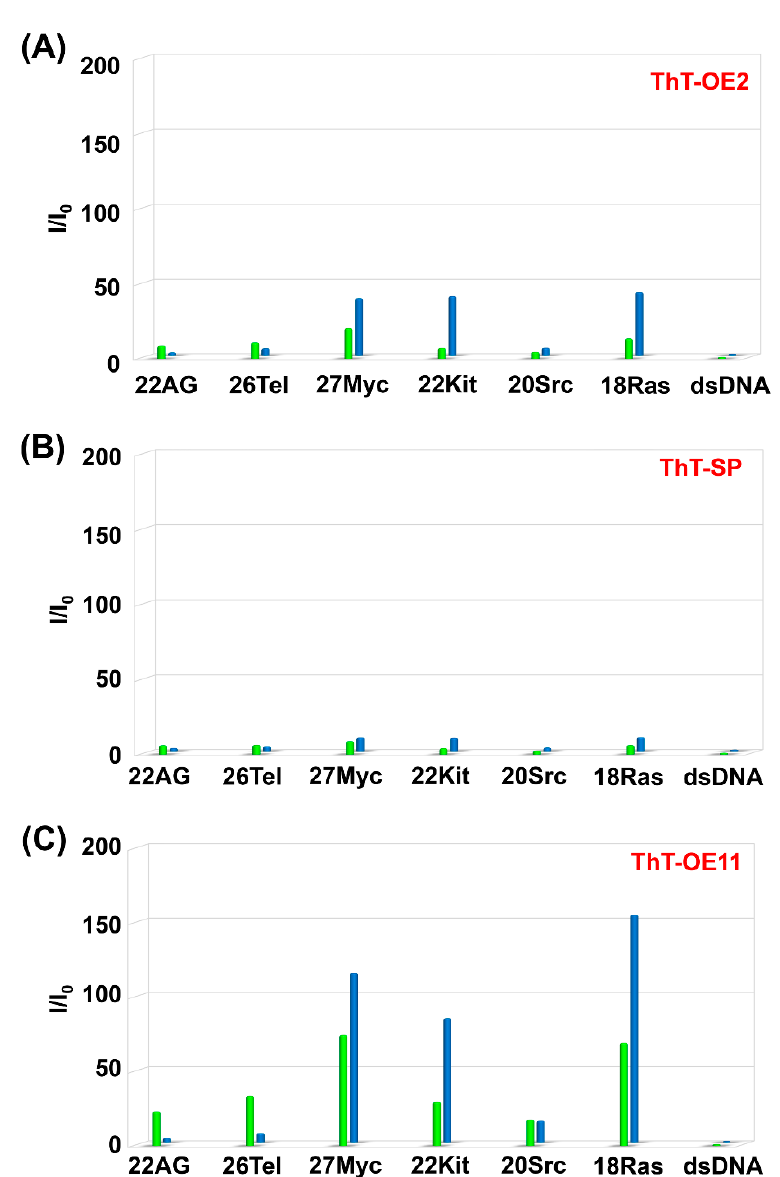
Figure 5. Relative fluorescence intensities (I / I 0 ) for ( A ) ThT-OE2, ( B ) ThT-SP, and ( C ) ThT-OE11 with each oligonucleotide in PBS140KM (green) and PBS153NM (blue). Here, I / I 0 is the ratio of the fluorescence intensities emitted upon the binding of the dye (3 µ M) to the oligonucleotide (15 µ M) and dsDNA (15 µ M; duplex concentration), respectively, in the same bu ff er. All samples were excited at 415 nm and the emissions were monitored at 485 nm.